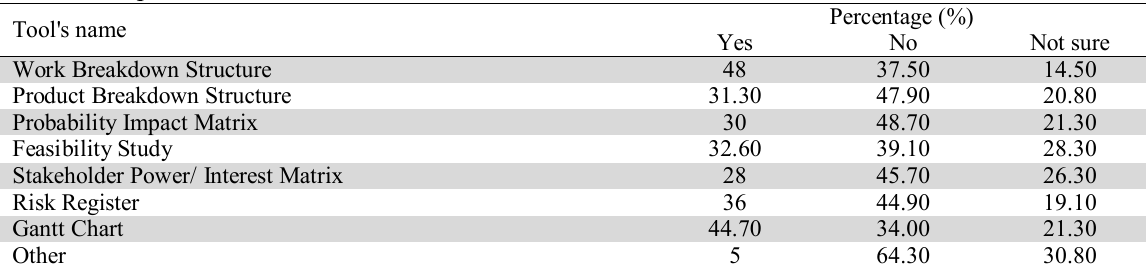
The use of specific tool